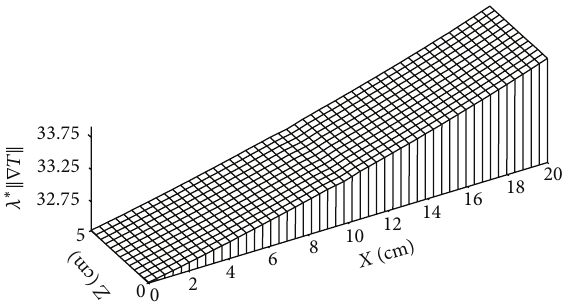
Figure 18: Distribution of heat flow due to conduction (in W/m 2 ) for 𝑡 = 4